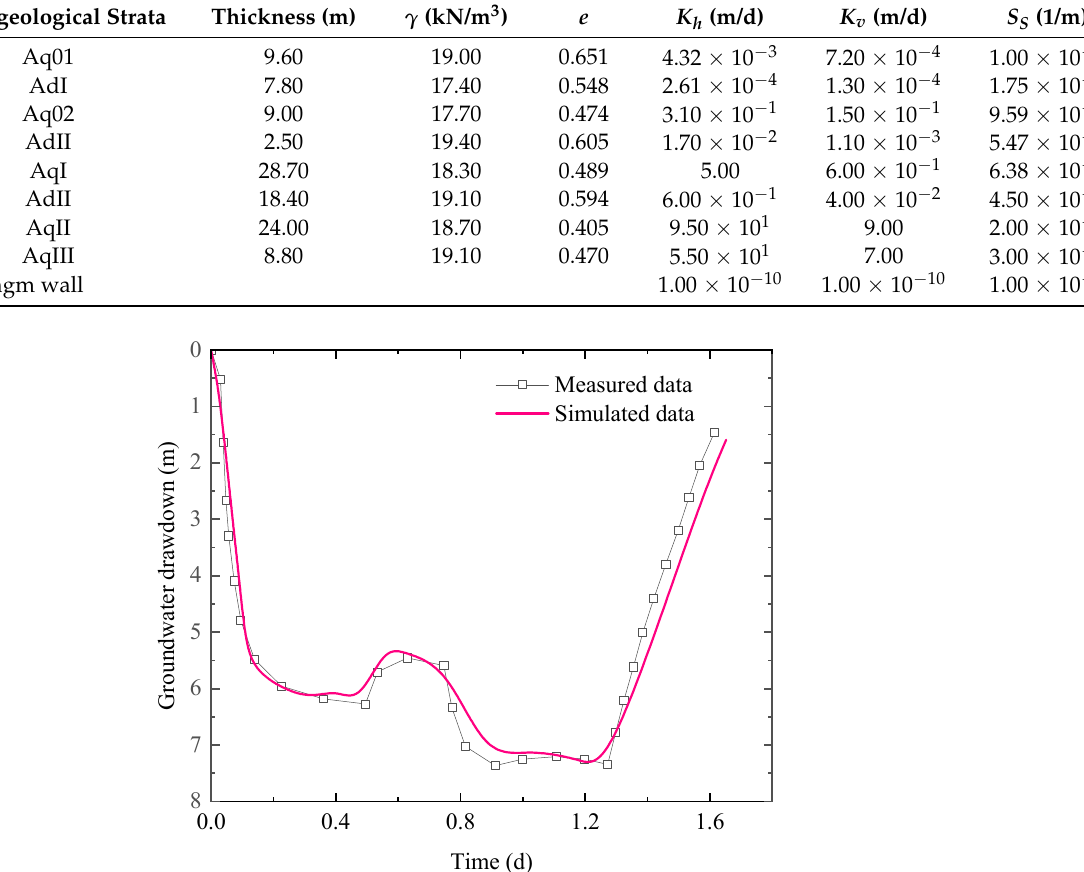
Table 2. Parameters used in the numerical model.